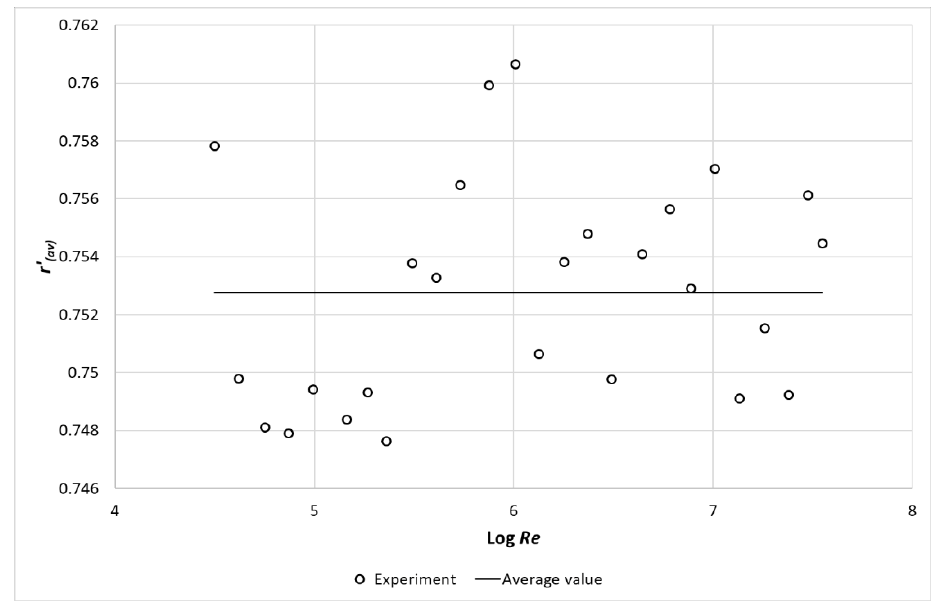
Figure 10. The average velocity radius for all 26 velocity profiles measured by Zagarola [3] on PSP. It is possible to see that the values tend to oscillate around a constant value for a given Re range. The average velocity radius range is <0.74763; 0.76064>. The range width is